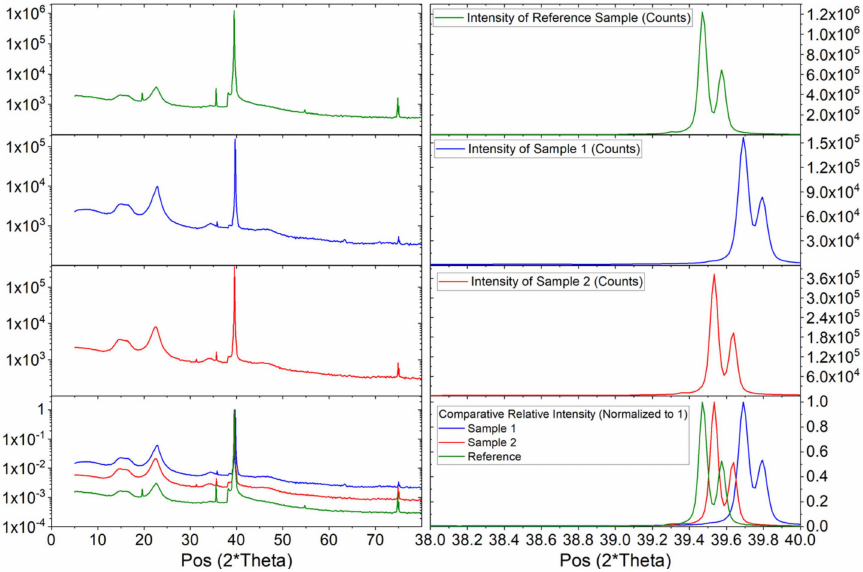
Figure 8. Top graph: The XRD diffractogram of a freshly fabricated TiO 2 sample from Crystal GmbH [55]. Next two graphs: The XRD diffractogram of our (80 keV ion-implanted 181 Hf compli- mented with sufficient thermal annealing) TiO 2 sample, measured after our TDPAC measurements. Bottom graph: the combined XRD diffractogram of the 3 abovementioned samples, with each corre- sponding intensity normalized concerning their individual highest recorded intensity. The left side of the graphs is presented as the log-10 plot of the measured intensity (counts) against the diffraction angle from 0–80 ◦ . For the top 3 graphs on the left side, the intensity starts from 1 × 10 − 2 , while for the bottom graph (on the left side), it starts from 1 × 10 − 4 . The right side of the graphs is presented as the linear plot of the measured intensity (counts) against the restricted domain of the diffraction angle from 38–40 ◦ . In all the right-sided graphs, the intensity starts from 0. We present the results of our XRD diffractions in this manner as: (a) the peaks in the domain of 39–40 ◦ dominate all other peaks and (b) to allow for the visualization of the successful resolution of the two most dominant peaks.